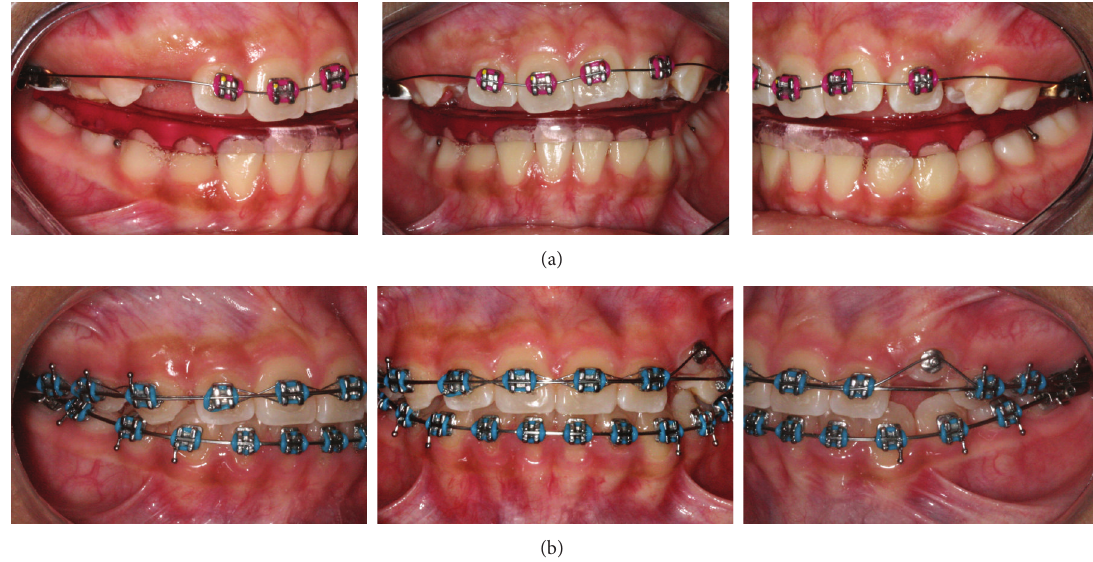
Figure 3: (a) Maxillary 2 × 4 associated with a mandibular bite plane; (b) treatment progress 0.017 󸀠󸀠 × 0.025 󸀠󸀠